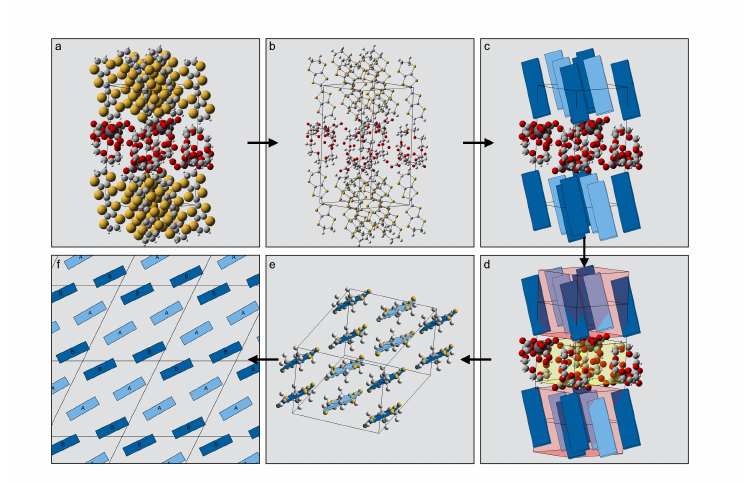
Figure 2. Views of various stages of the crystal structure analysis algorithm. The individual images show the initial unit cell consisting of atoms within a lattice ( a ), detected molecules ( b ), detected cation molecules shown as rectangles ( c ), detected anisotropy and layers ( d ), a new unit cell consisting of only the cation layer ( e ), and a two-dimensional depiction of the cation layer ( f ). In this example, the material is β ”-(ET) 4 [(H 3 O)Cr(C 2 O 4 ) 3 ] 2 [(H 3 O) 2 ] 5 H 2 O, as reported in